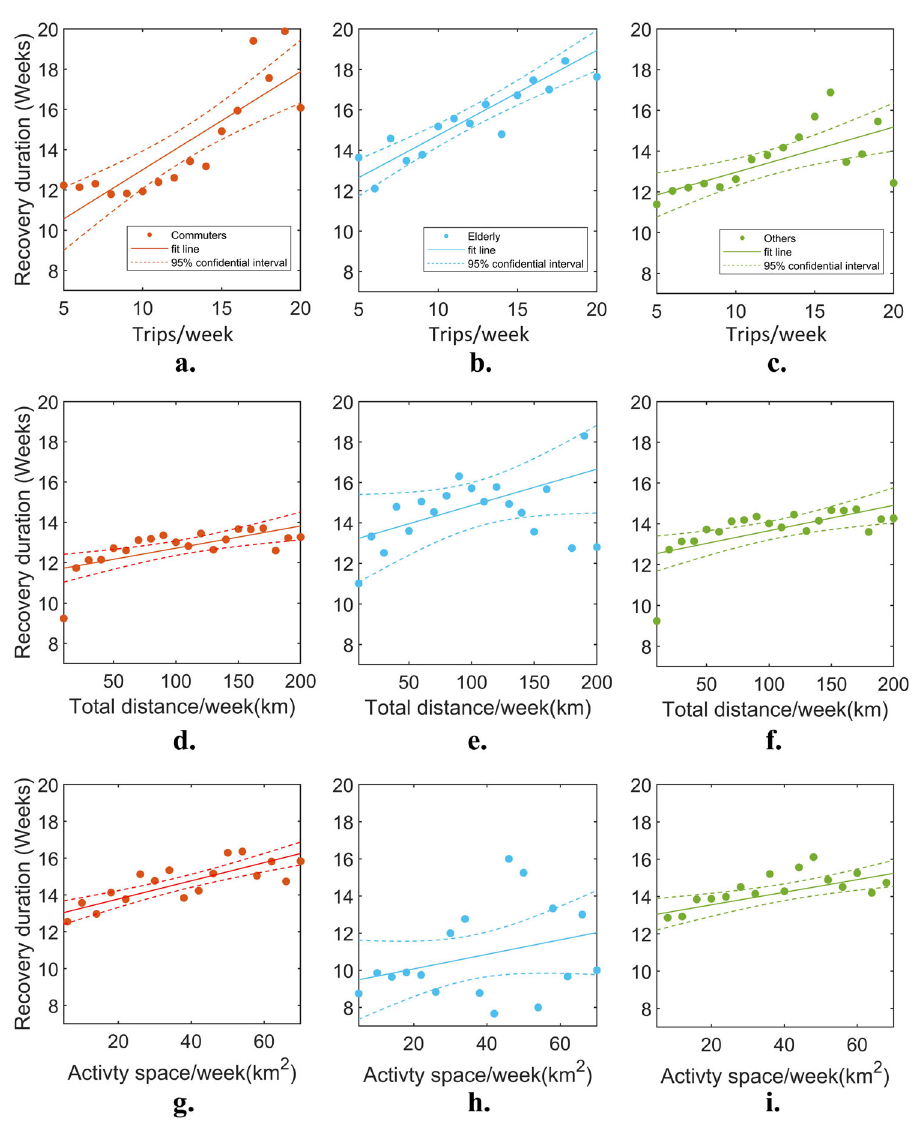
Fig. 5 Correlations between travel recovery duration and pre-pandemic mobility level. a – c After the fi rst COVID-19 wave, subjects whose trips in a week decreased to zero are selected ( n = 15,395). Their average number of trips/week before COVID-19 are calculated. The recovery duration is de fi ned as from the week when trips decreased to zero to the week when trips recover to the pre-pandemic level. The regression analysis is conducted with trips/week before COVID-19 ( x ) and the recovery duration ( y ). We obtain y com = 0.49 x + 8.13, R 2 = 0.71; y eld = 0.42 x + 10.55, R 2 = 0.82; y oth = 0.22 x + 10.74, R 2 = 0.48. d , f Subjects whose total distance decreased to zero during COVID-19 are selected ( n = 15,402). The regression is performed with total distance/week before COVID-19 ( x ) and recovery duration ( y ). The results are given below y com = 0.01 x + 11.61, R 2 = 0.44; y eld = 0.02 x + 13.06, R 2 = 0.17; y oth = 0.01 x + 12.41, R 2 = 0.39. g – i subjects whose activity space decreased to zero during the fi rst pandemic wave are selected ( n = 15,402). The regression is performed with activity space/week